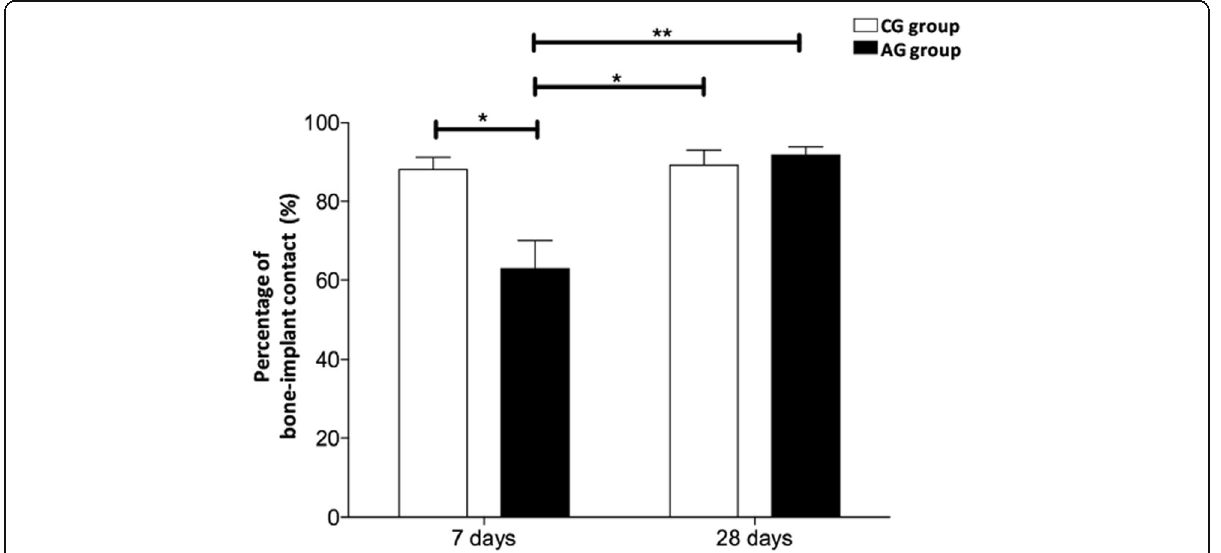
Fig. 1 Effect of low-dose aspirin regarding bone-to-implant (BIC). The data represent mean ± SE ( n = 8 animals/group). Asterisk indicates significant difference between the groups (* p < 0.01; ** p < 0,001, ANOVA and post hoc